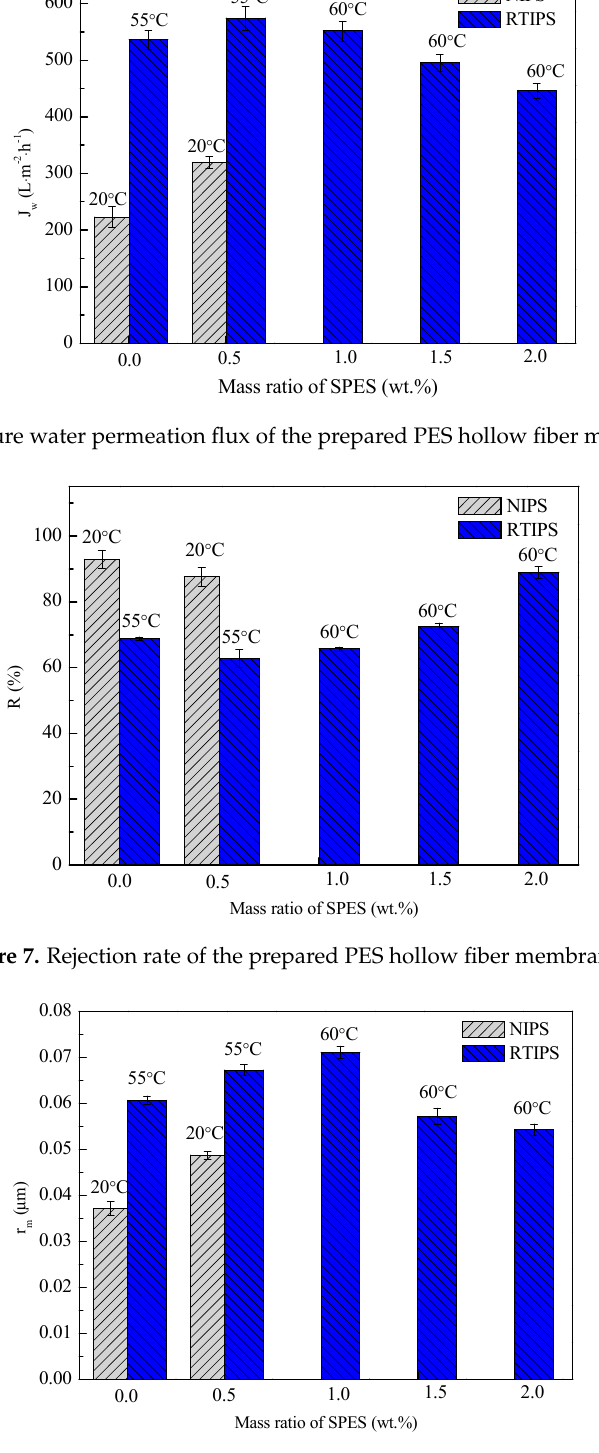
Figure 8. Mean pore size of the prepared PES hollow fiber membranes.